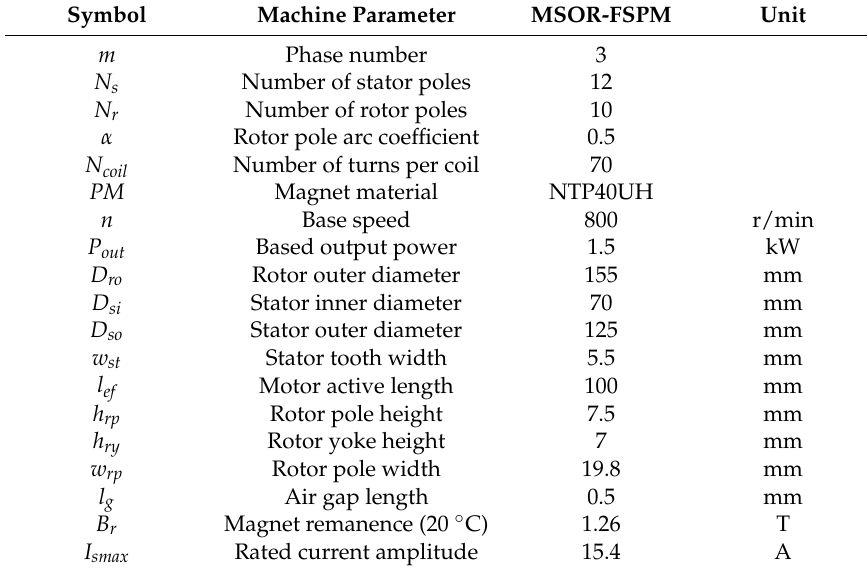
Table 1. Main parameters of the initial designed 12-slot/10-pole MSOR-FSPM motor.